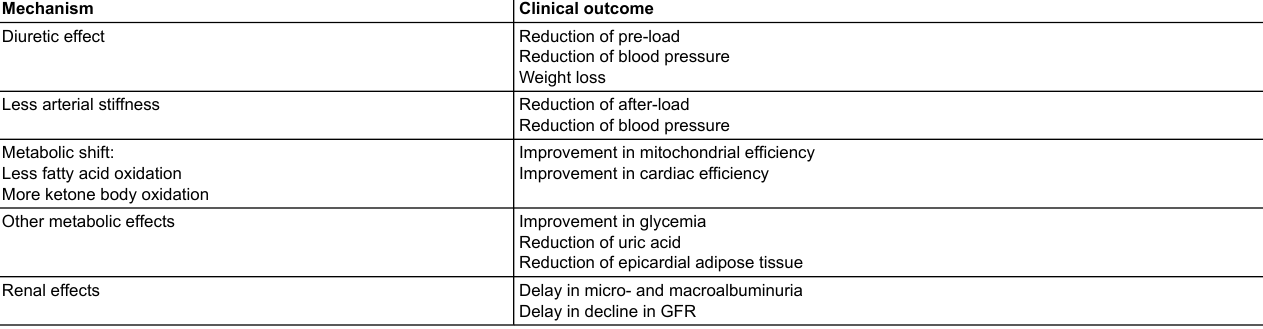
Table 1: Proposed mechanisms of the beneficial cardiovascular effects of SGLT2 inhibitors. Mechanism